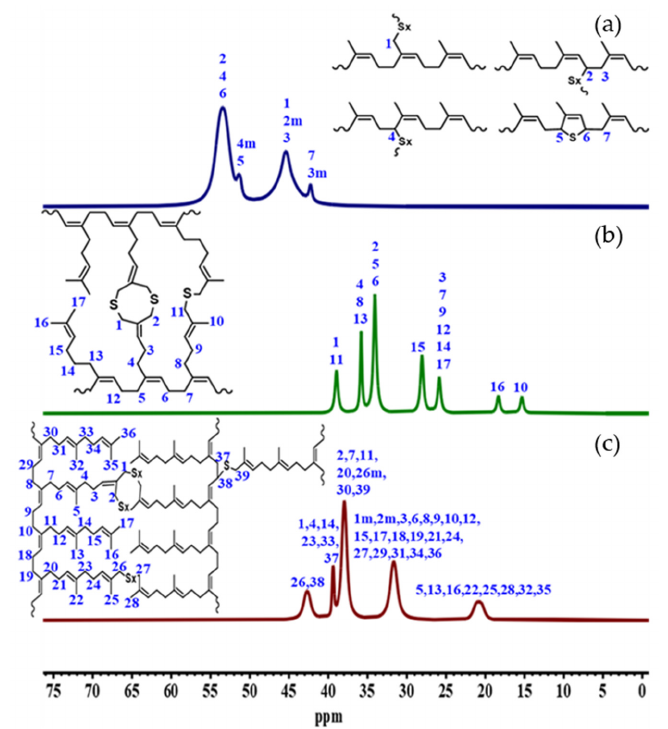
Figure 8. 13 C CP-MAS solid-state NMR spectrum of crosslinked ( a ) PI-H, ( b ) PM-H, and ( c ) PF-H using the CV system (the spectra have been treated with deconvolution and noise removal).